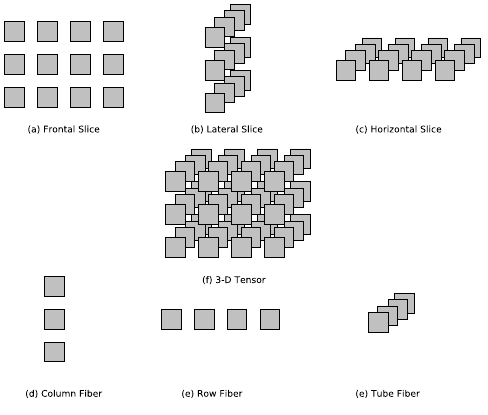
Figure 2. a single slice and a fiber of a 4 × 3 × 4 Tensor